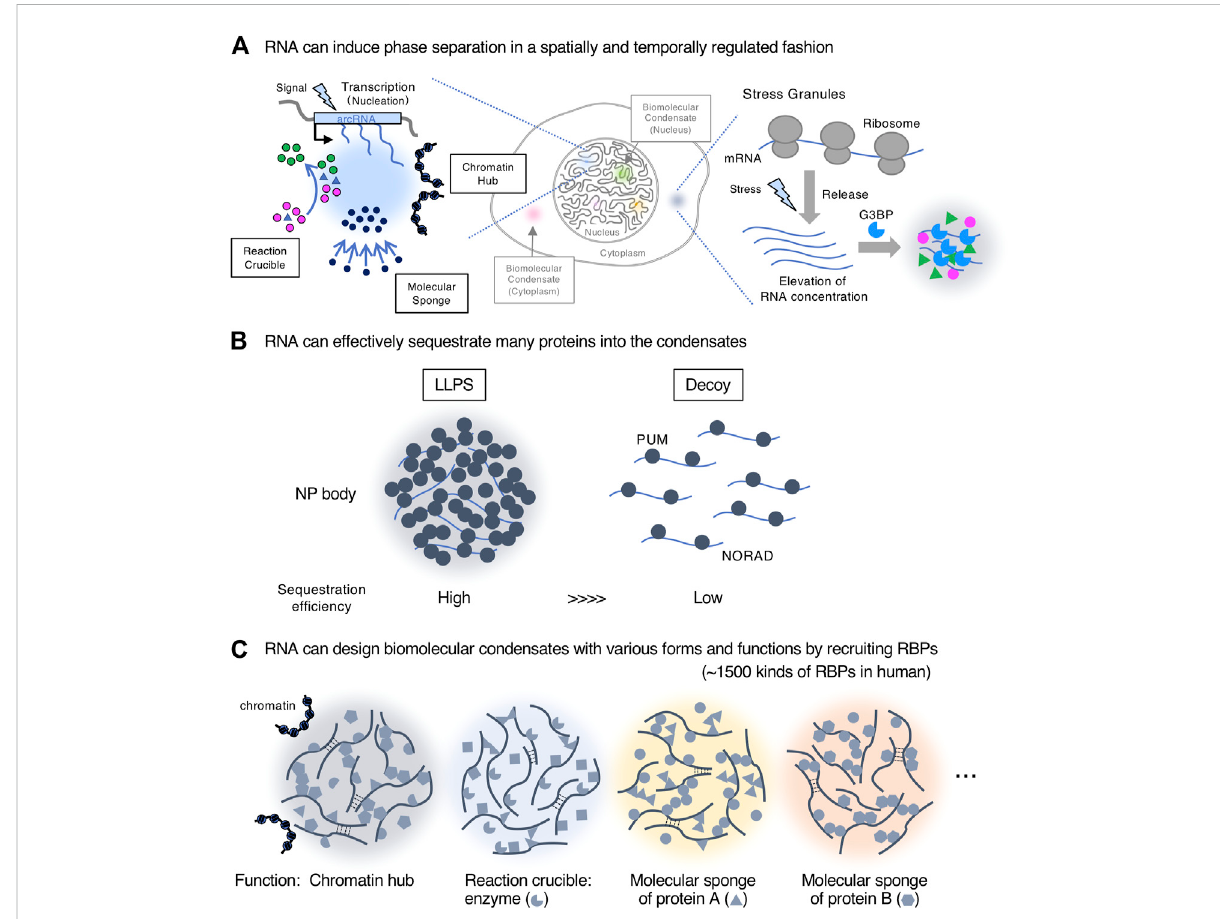
FIGURE 2 RNAs are suitable biomolecules for scaffolds of biomolecular condensates. (A) . RNA can induce phase separation in a spatially and temporally regulatedmanner.TranscriptionofnucleararchitecturalRNAs(arcRNAs)(nucleationevent)inducesnuclearcondensateswithrolessuchasreaction crucible, molecular sponge, and chromatin hub. The stress granule is shown as an example of the formation of cytoplasmic condensates with RNA scaffolds. (B) . RNA can effectively sequester many proteins into the condensates by liquid-liquid phase separation (LLPS) compared with a stoichiometricdecoy mechanism.The NP (NORAD-PUM) body is shown as an example. (C) . RNAcan createbiomolecular condensateswith various forms and functions by recruiting a wide variety of RNA-binding proteins (RBPs) (~1,500 kinds of RBPs in